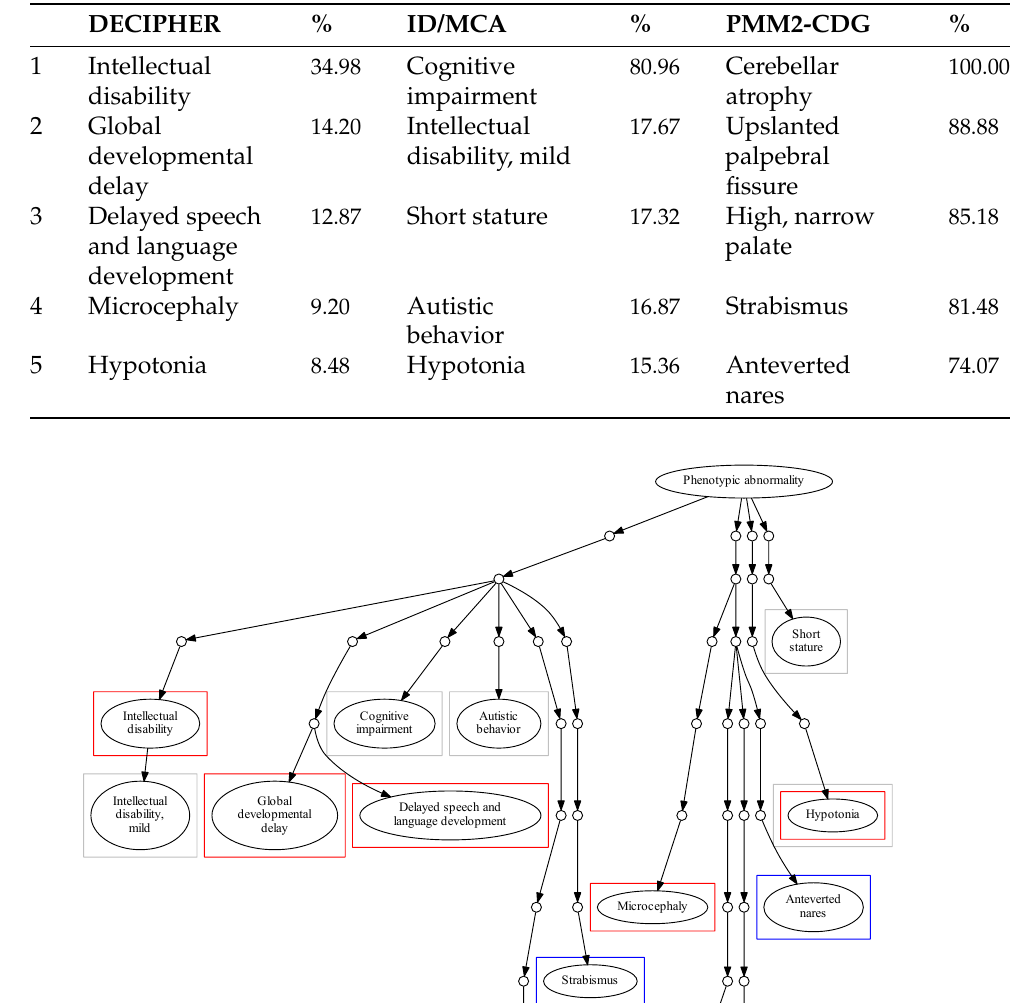
Table 4. Top five most frequent HP0 terms in DECIPHER, ID/MCA and PMM2-CDG datasets.